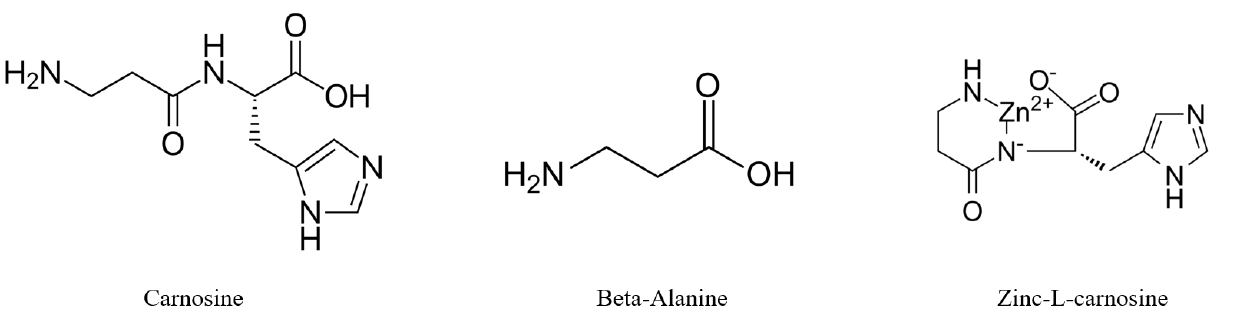
Figure 1. Chemical structure of carnosine, zinc-L-carnosine and beta-alanine.